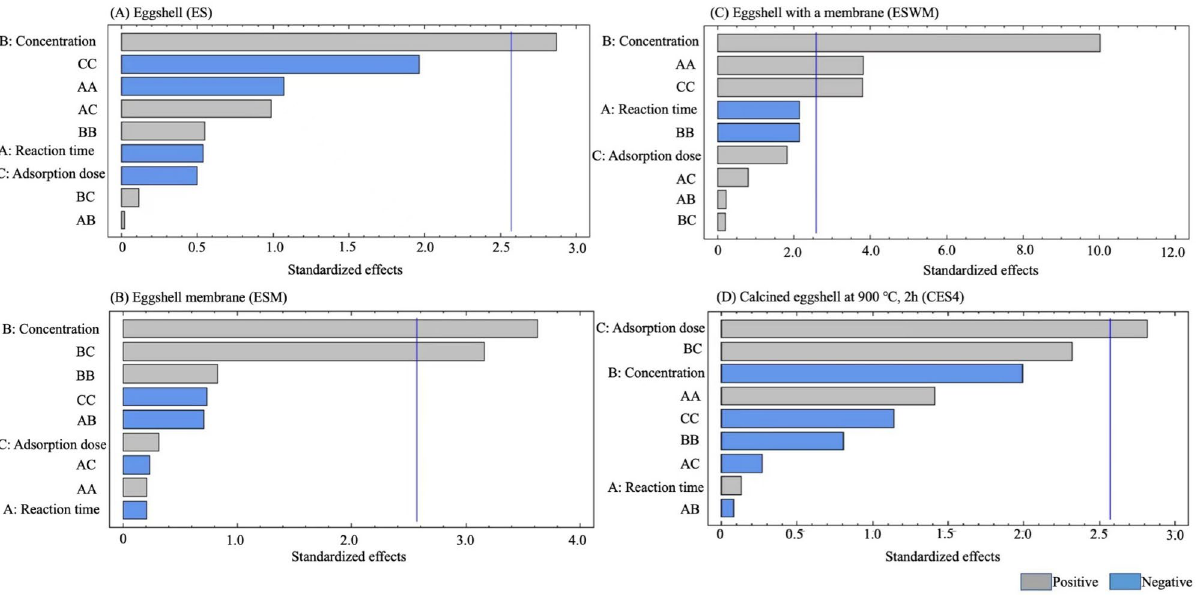
Figure 4. Pareto chart standardized effects for the adsorption of 4 different eggshells in copper ion solution. ( A ) Eggshell (ES); ( B ) eggshell membrane (ESM); ( C ) eggshell with a membrane (ESWM); ( D ) calcined eggshell at 900 °C, 2 h (CES4).